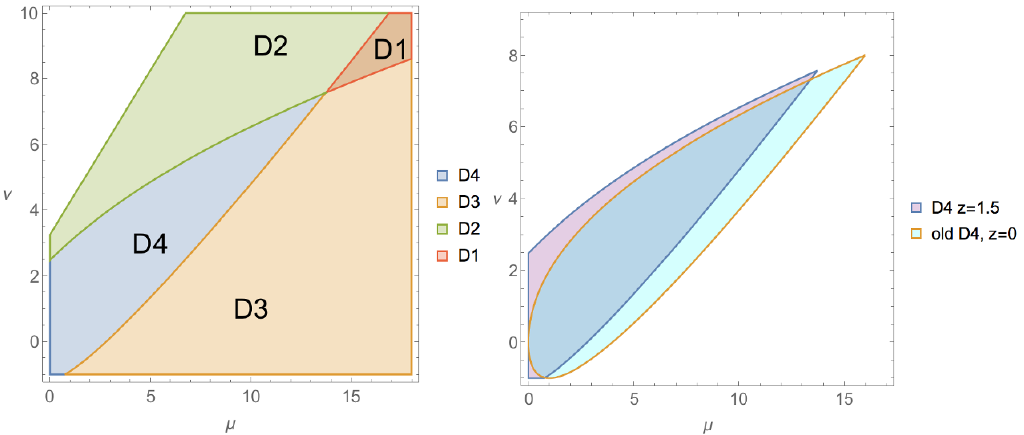
Figure 28 . On the left, plot depicting the various parameter space for regions D1-D4 for (cid:12)xed z = 1 : 5. On the right, a comparison of the size of region D4, for z = 0 and z = 1 :